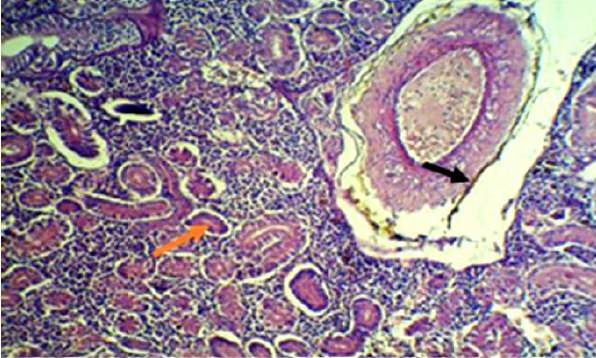
Figure 1. Histopathological section of kidney shows congestion and thickening of blood vessels wall ( ) and shrinking of epithelial cells lining the renal tubules ( ) (H&E,